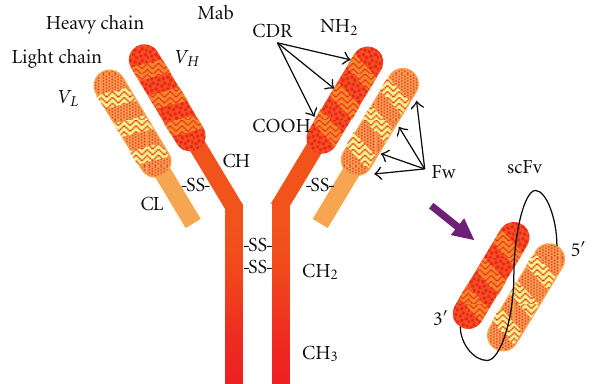
Figure 1: Antibody model showing subunit composition and do- main distribution along the polypeptide chains. Single-chain frag- ment variable (scFv) antibody generated by recombinant antibody technology appears in the shaded